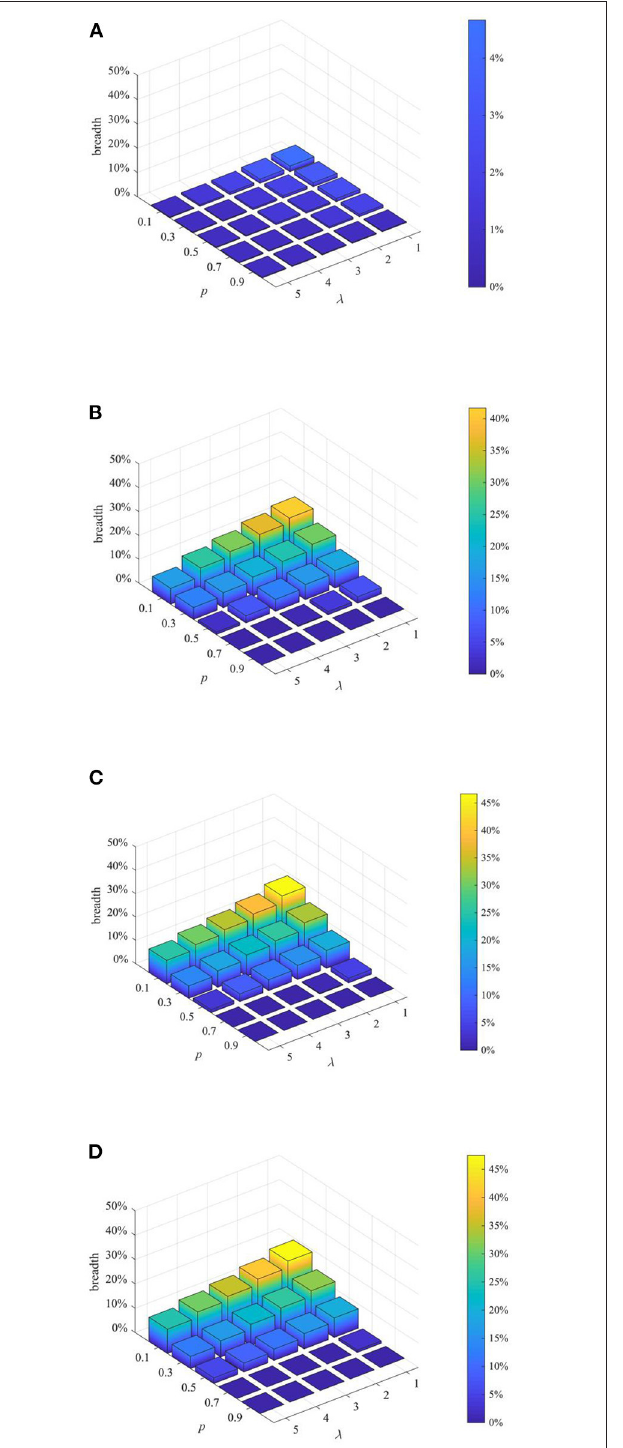
FIGURE 13 | Network activity under different strategy combinations. (A) t = 1. (B) t = 15. (C) t = 30. (D) t = 45.